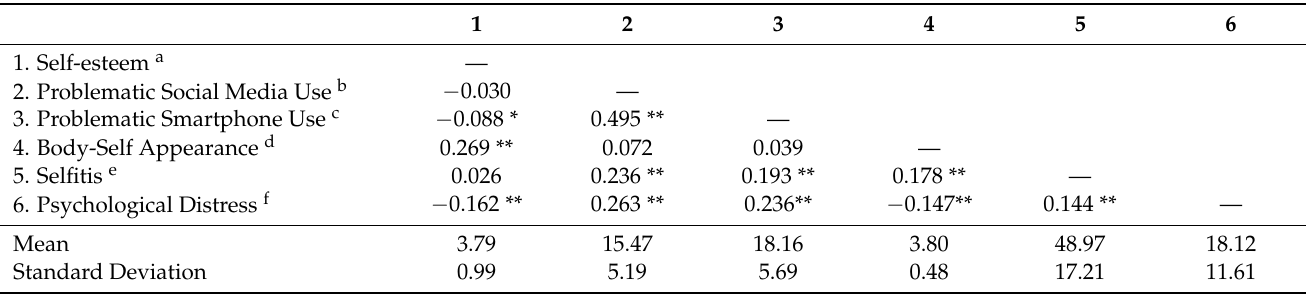
Table 2. Correlation